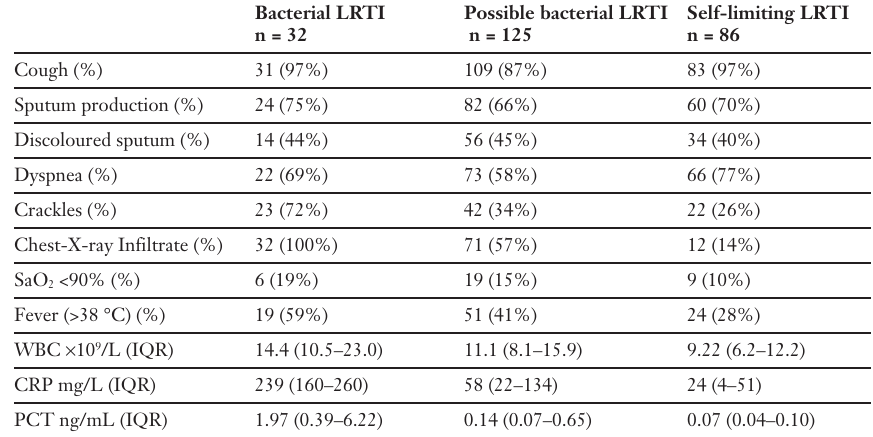
Table 3 Usefulness of clinical and laboratory pa- rameters to identify bacterial LRTI requir- ing antibiotic ther- apy. Three different analyses are shown (x, y, z) x excludes patients with possi- ble bacterial infection (n = 118), y includes patients with possi- ble bacterial infection classed as bacterial LRTI (n = 243) and z includes patients with possible bacter- ial infection classed as self-limiting LRTI (n =